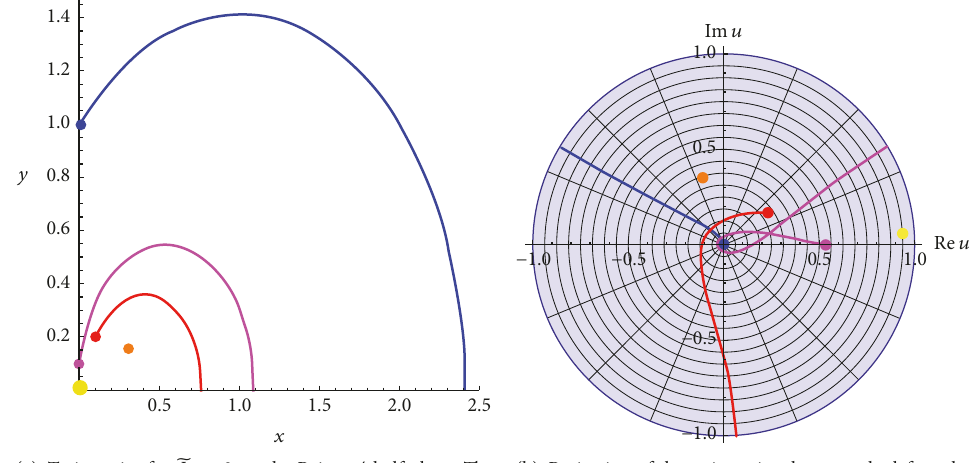
(b) Projection of the trajectories shown at the left to the hyperbolic punctured disk Figure 7: Numerical solutions for Φ = 0 and 𝛼 = 𝑀 0 /3 .